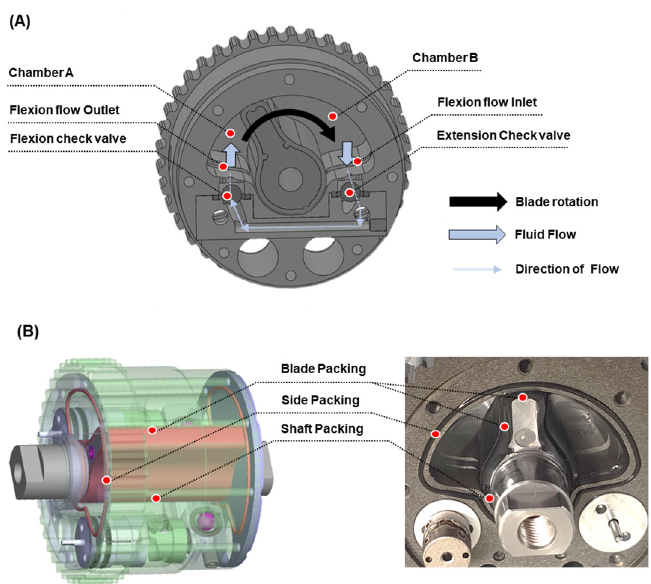
Figure 2. Design of rotary hydraulic cylinder: ( A ) flow path structure of rotary hydraulic cylinder and fluid flow during knee flexion; ( B ) 3D modeling of packing in the rotary hydraulic cylinder and actual packing structure.